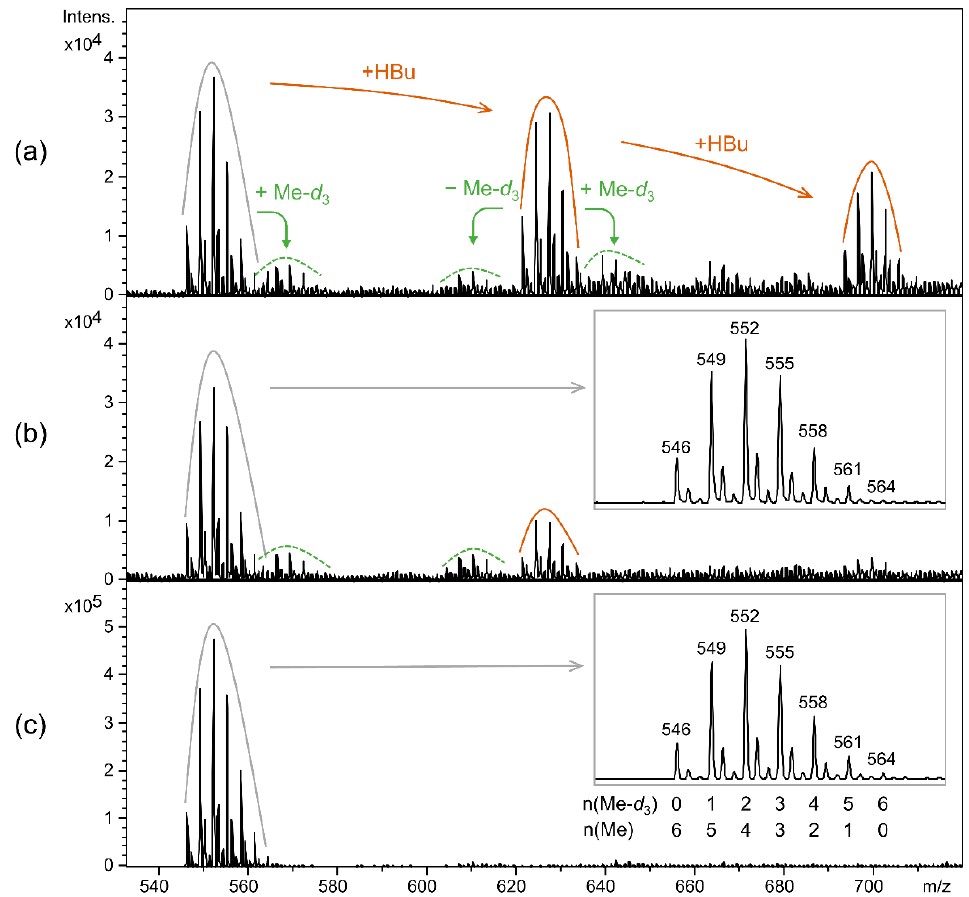
Figure 4. ( a ) Cutouts of LC-MS spectra of deBnMC-2 (Method-1, Table 1) showing DP-2 and its additional side-products when debenzylation is performed in one-pot (peaks of DP-2 + 3 HBu overlap with the peaks of DP-3 and are not shown) versus ( b ) when the reaction mixture is purified before alkaline hydrolysis (deBnMC-2*, Method-2a, Table 1). Only trivial amounts of DP-2 + 3 HBu (at the background noise level of LC-MS) were detected by LC-MS; ( c ) a cutout of the LC-MS spectrum of MC-2 is displayed for comparison. Insets exhibit zoomed-in views of the main methyl substitution profiles of corresponding spectra. Samples are deuteromethylated, partially hydrolyzed, and labeled with m -ABA. For details refer to the Materials and Methods Section 2.7.